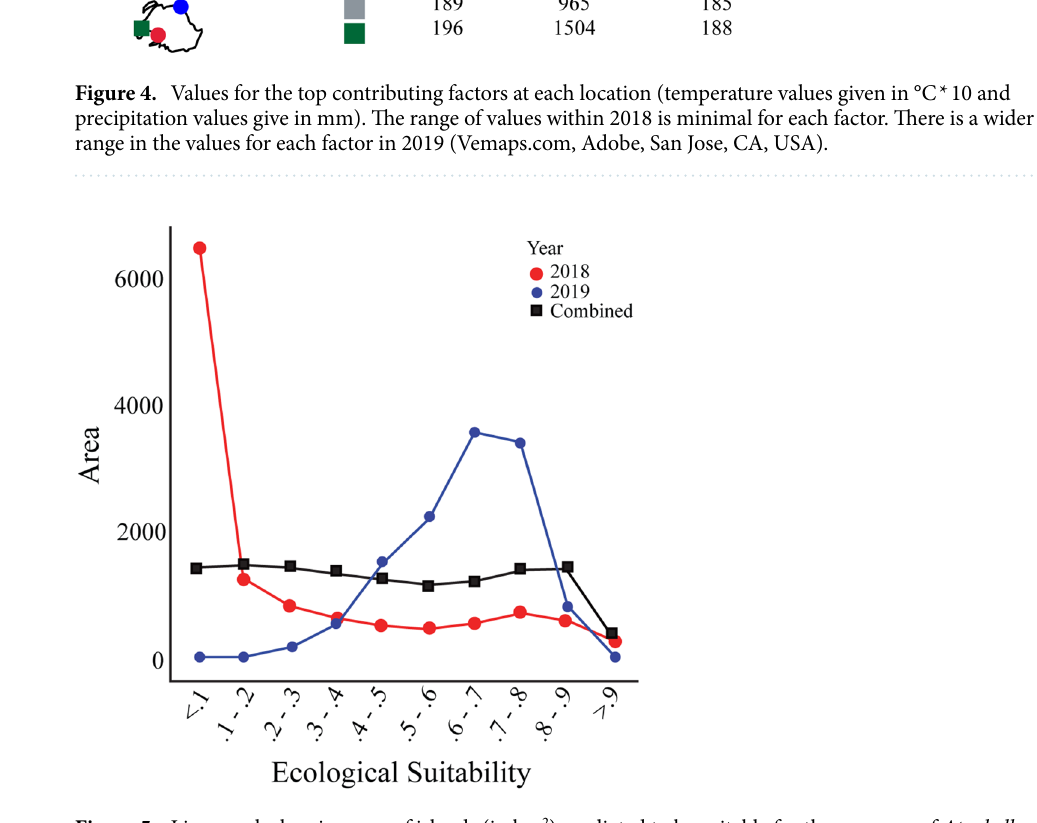
Figure 5. Line graph showing area of islands (in km 2 ) predicted to be suitable for the presence of Atyphella at 10% intervals (upper probability included in